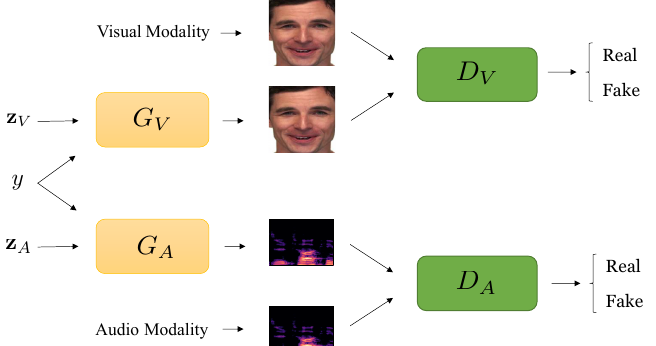
Figure 2. The structure of our multimodal conditional GAN. The audio modality and the visual modality are generated by G A and G V , respectively. Category information is used as their shared input to generate new data of different categories. Additionally, in the generated multimodal data, the correlation between the audio modality and the visual modality is modeled to approximate the real multimodal